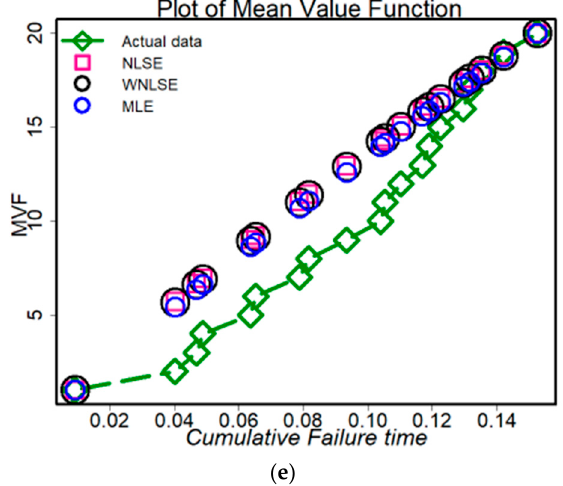
Figure 7. Comparison of the estimating techniques for the NHPP–NPF model for ( a ) DS1, ( b ) DS2, ( c ) DS3 ( d ) DS4, and ( e ) DS5. (left to right).